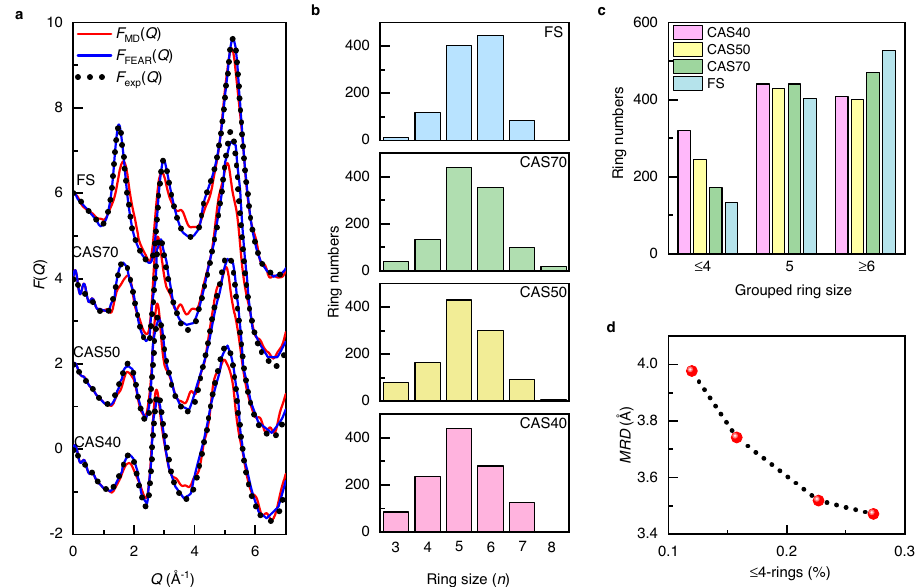
Fig. 7 | FEAR simulation con fi rmation that MRD can be used to represent the percentage of small-sized rings. a Measured (black dotted curves) and two simulated, MD (red solid curves) and FEAR (blue solid curves) total reduced structurefactors F ( Q )for three CASand FS glasses, witheach glass ’ F ( Q )s vertically